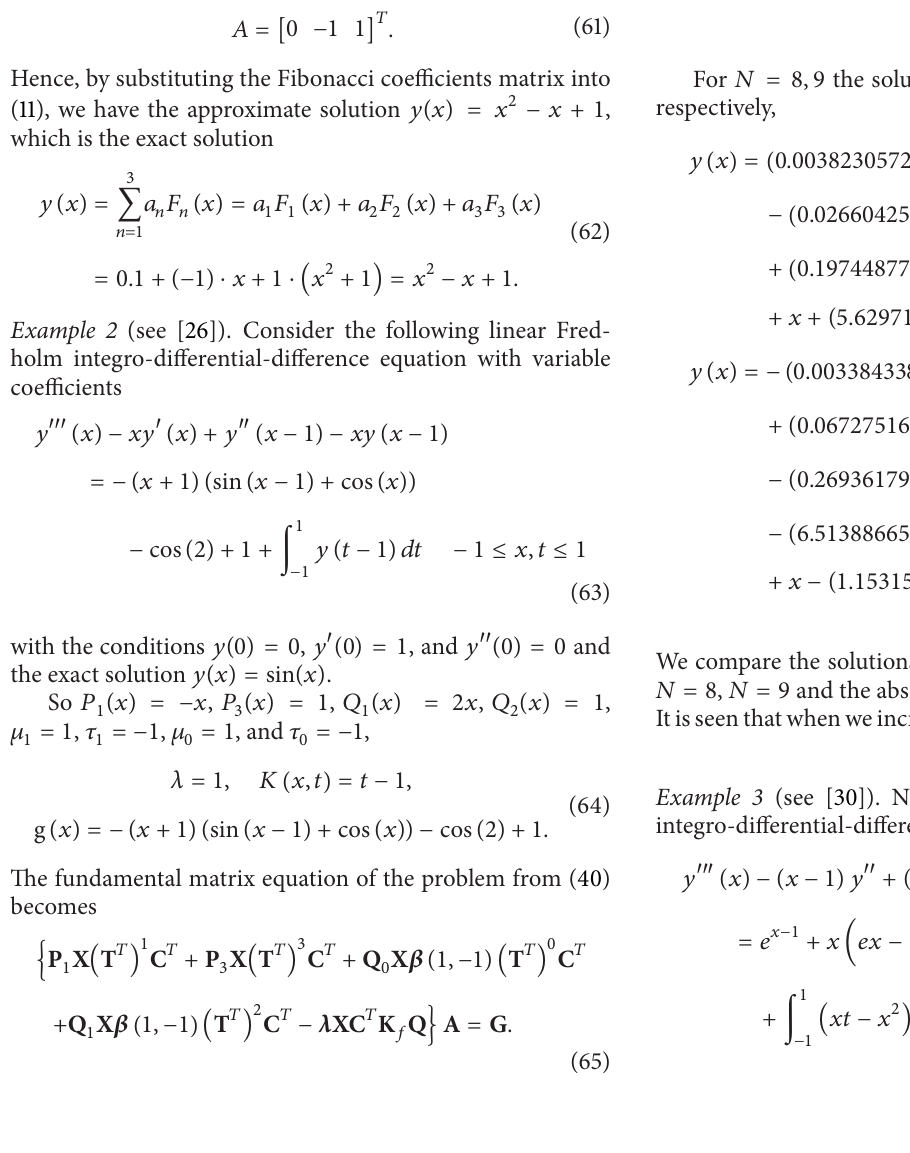
Figure 1: Numerical and exact solutions of Example 2 for 𝑁 = 8,9